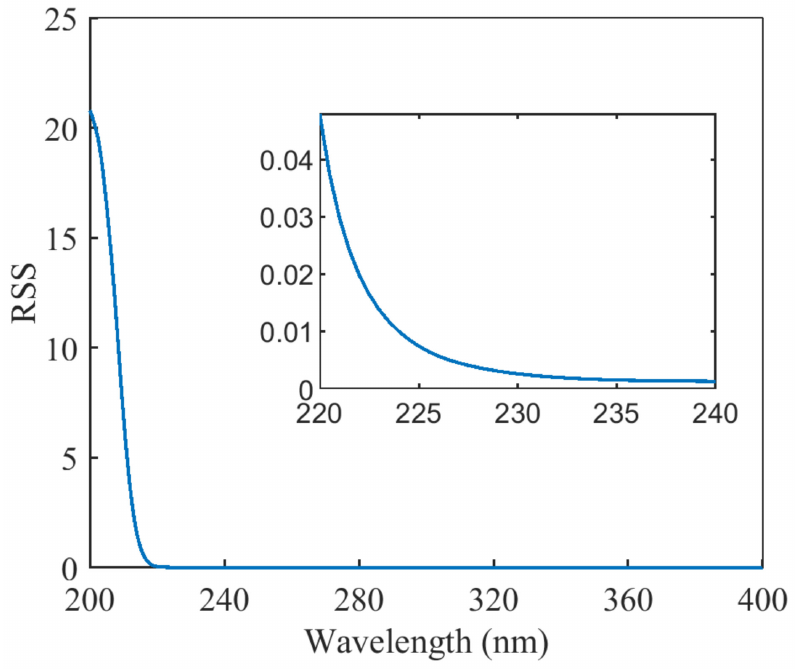
Figure 3. RSS at different